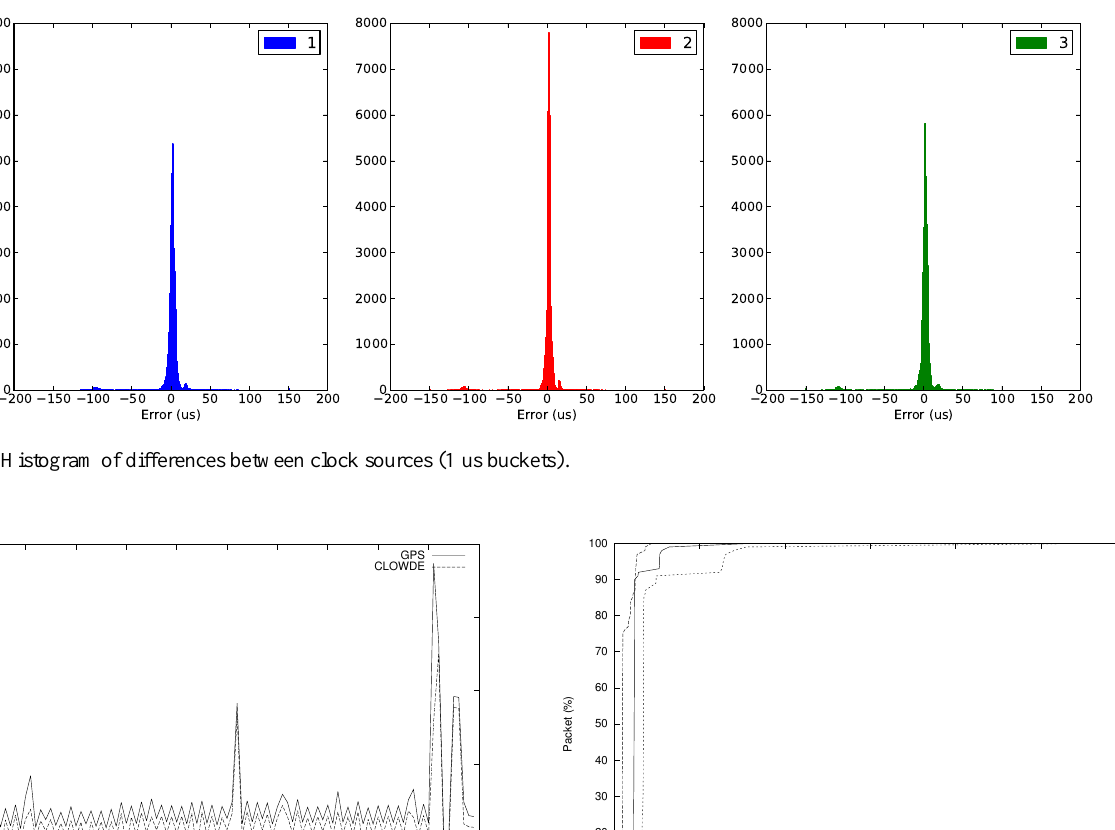
Fig. 15: Clowde delay correction error